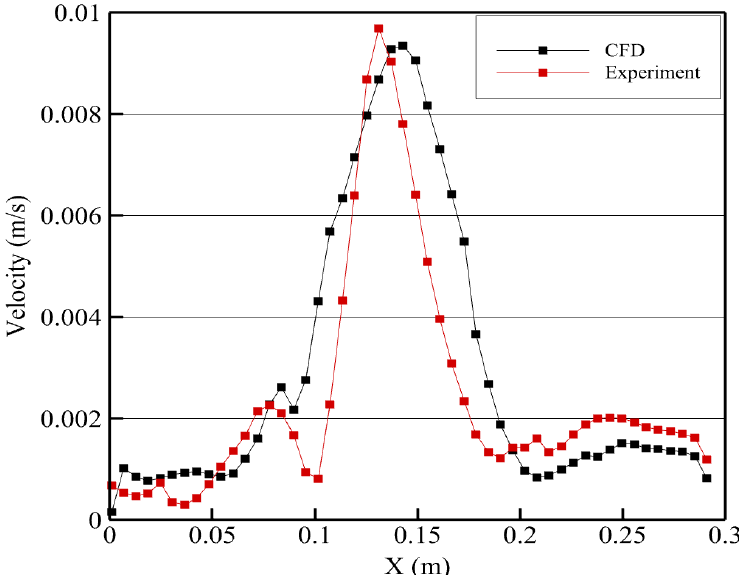
Figure 9. Velocity profile at Y = 0.16 m.